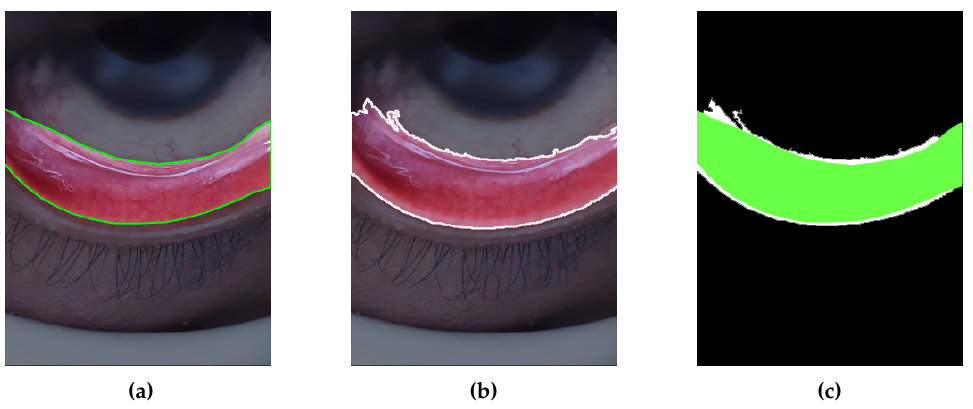
Figure 10. ( a ) Manually segmented conjunctiva used as ground truth. ( b ) Automatically segmented conjunctiva obtained by the proposed approach. ( c ) Visualization of the overlapping between green ground truth image and white automatically segmented image ( F 1 = 0.904, accuracy = 96.41%).